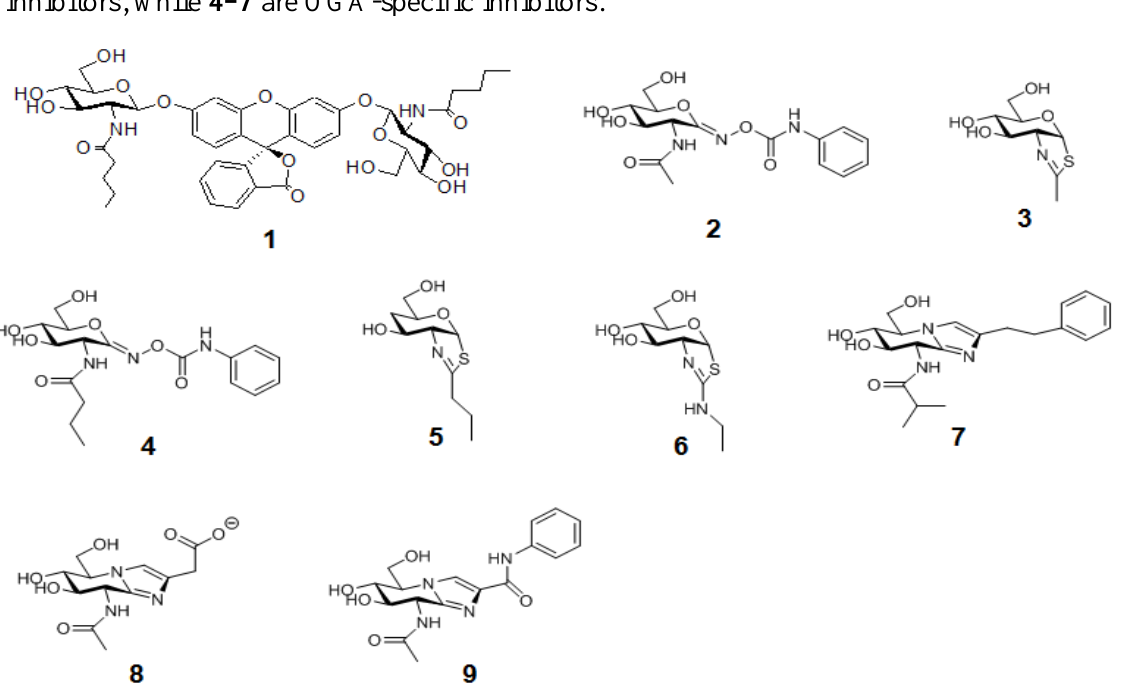
Figure 10. The structures of OGA-specific pentanamide FDGlcNAc substrate 1 analogue and OGA inhibitors discussed in the text. Compounds 2 , 3 , 8 , 9 are nonspecific OGA inhibitors, while 4–7 are OGA-specific